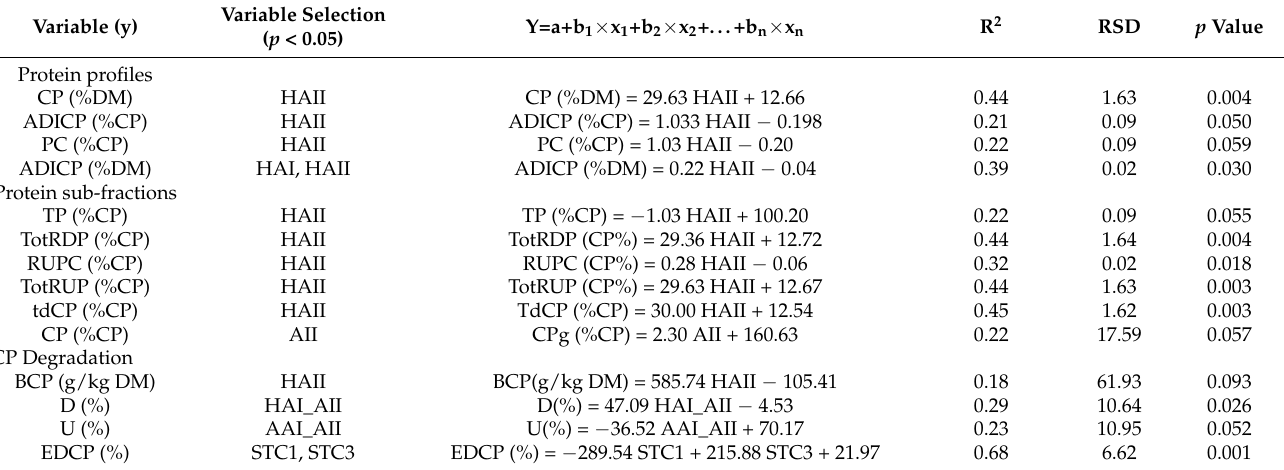
Table 3. Multiple Regression Analysis to Study Association between Protein Spectral Parameters and Protein-Related Nutrition Values of Cool-Season Adapted CDC